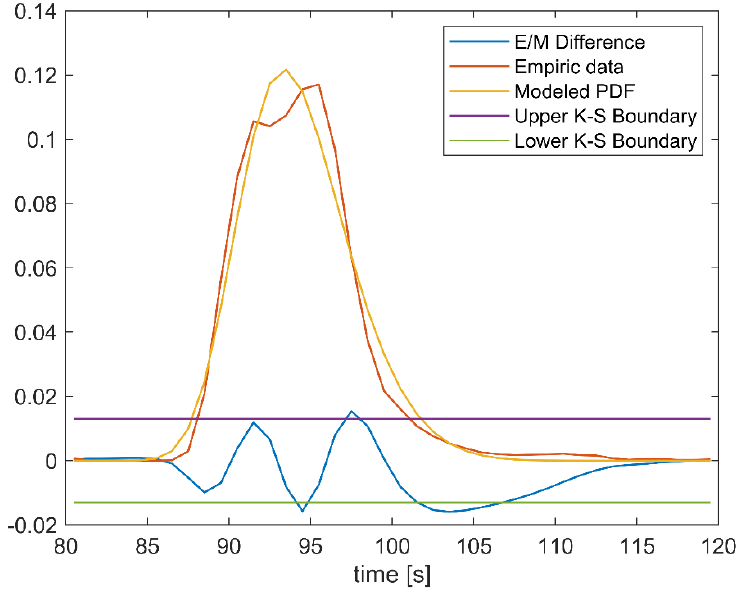
Figure 20. Statistical modeling for July 2018.